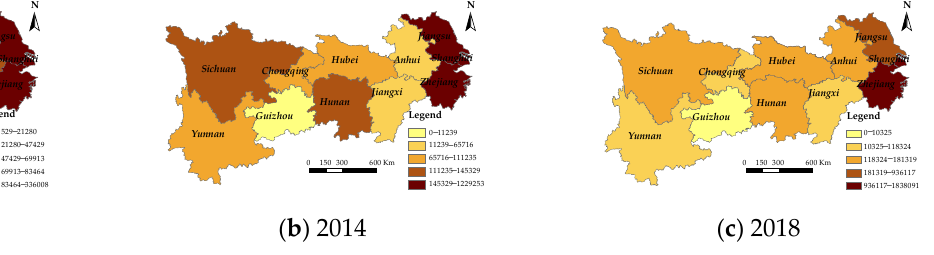
Figure 3. Investment amount of OFDI in the Yangtze River Economic Belt.